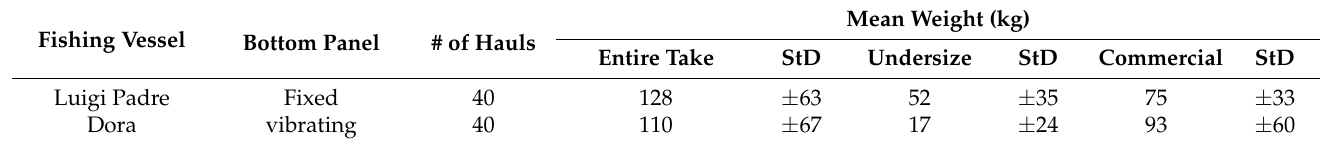
Table 1. Entire take, undersize capture, commercial catch with traditional vs. innovative